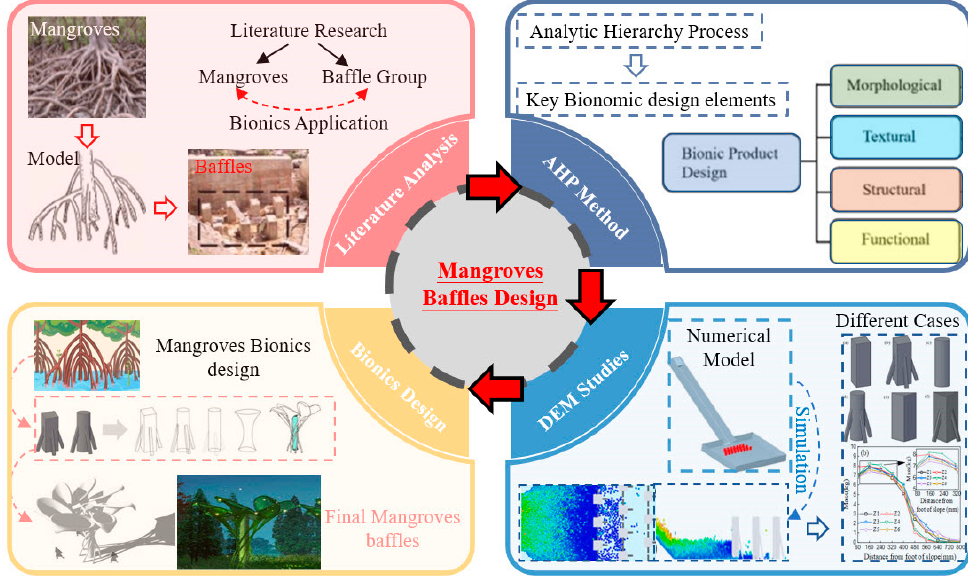
Figure 6. The scientific research steps of this study.